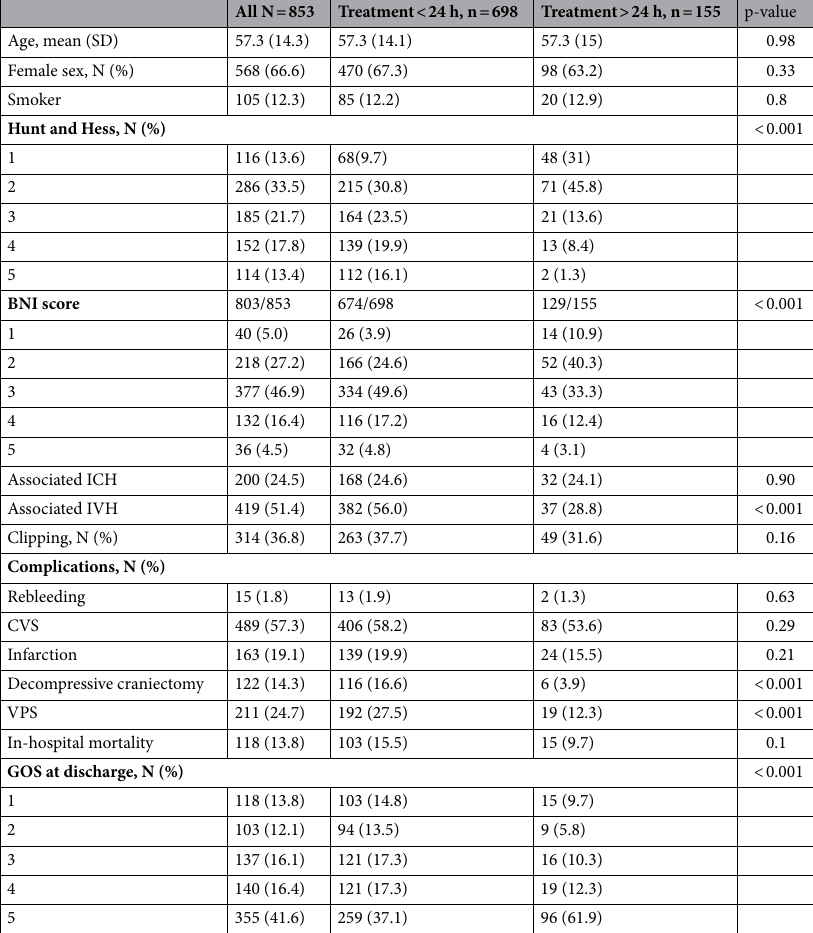
Table 1. Baseline characteristics. BNI Barrow Neurological Institute, CVS cerebral vasospasm, GOS Glasgow Outcome Scale, ICH intracerebral haemorrhage, IVH intraventricular haemorrhage, SD standard deviation, VPS ventriculoperitoneal shunt. Significant values are in bold.